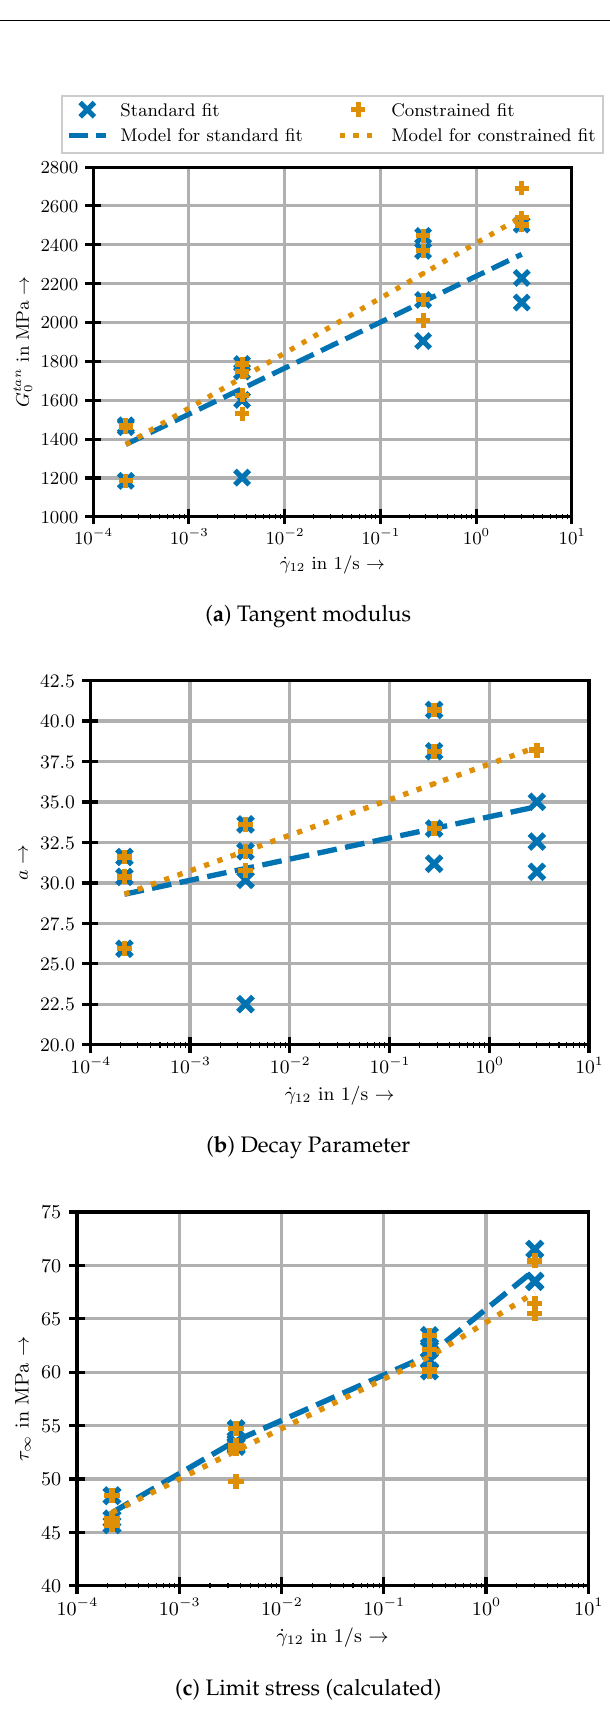
( c ) Limit stress (calculated) Figure 9. Dependency of material parameters on the strain